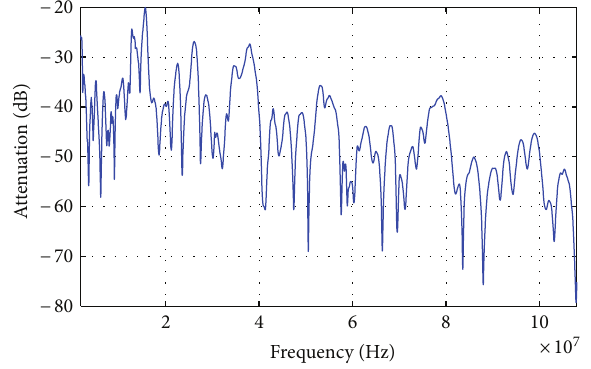
Figure 8: HomePlug AV2 measurement campaign. Example of channel measurement.